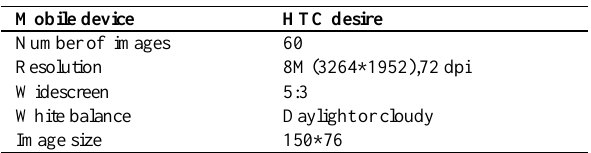
Table 1. Details of eye